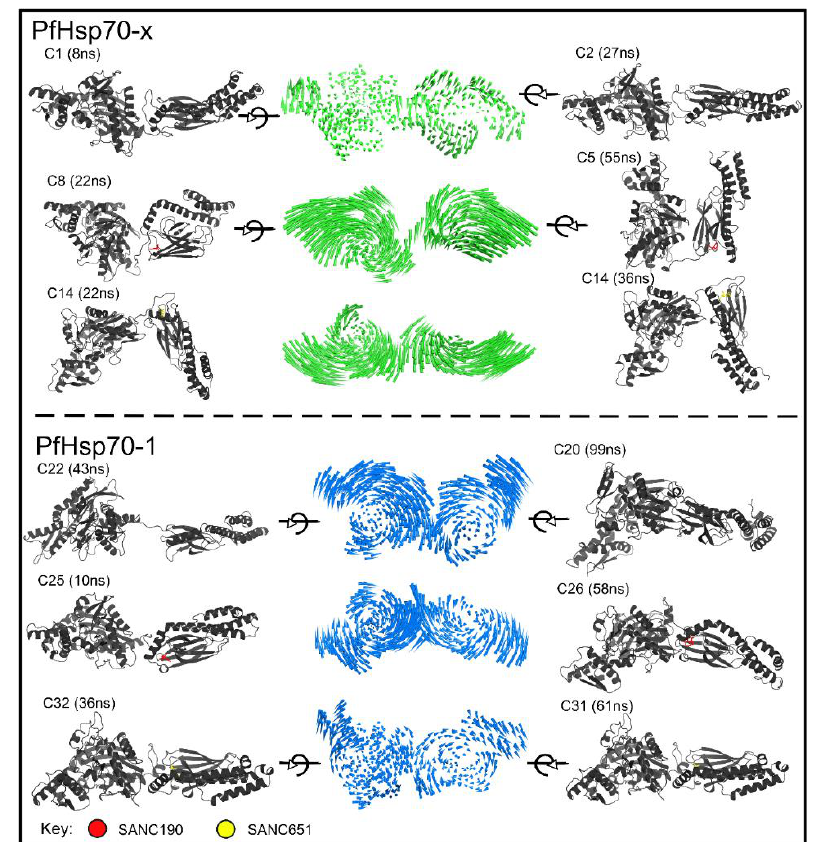
Figure 7. Representative ligand-free and ligand-bound sub states (colored grey) of PfHsp70-x and PfHsp70-1. Structures were obtained from conformation clusters occupying low energy basins as depicted in Figure 6. The middle panel displays porcupine plots illustrating the direction and magnitude (indicated by the length of the porcupine) of dominant protein motions observed during simulation. Color code: Green: PfHsp70-x, Blue: PfHsp70-1. Circular arrows indicate ~90˚ rotation of structures.